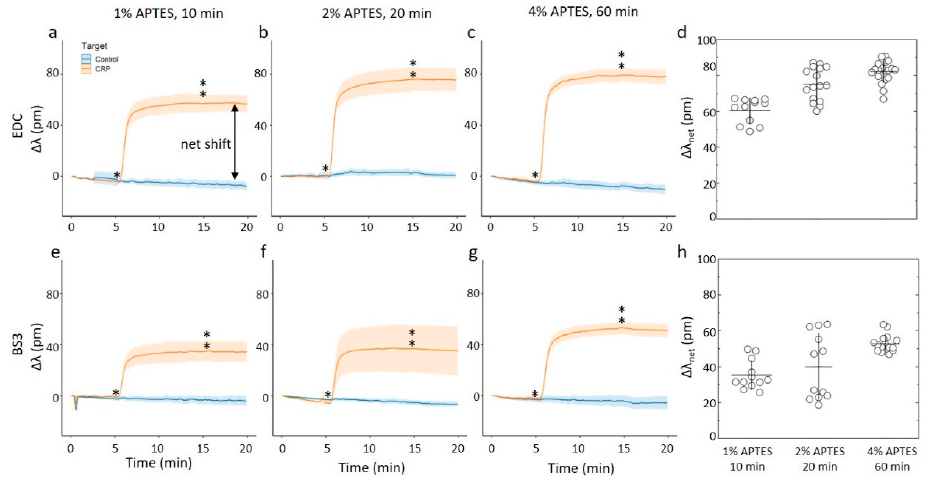
Figure 6. ( a – c , e – f ) Online measurements of CRP capture on ring resonator sensor chips silanized with APTES using 1 mM acetic acid as the silanization solvent. The assay steps consisted of a PBS-BSA rinse for 5 min before a 2.5 ug / mL CRP in BSA-PBS for 10 min and a final PBS-BSA rinse for 5 min. Single- and double-stars marks start and end of CRP in BSA-PBS step respectively. For these experiments, at least 12 rings were used for technical replicates. ( a – c ) CRP capture onto chips where the anti-CRP capture molecule has been immobilized using by carbodiimide chemistry onto chips silanized using APTES concentrations and durations of ( a ) 1% APTES, 10 min, ( b ) 2% APTES, 20 min, and ( c ) 4% APTES, 60 min. ( d ) The average net shift in resonance wavelength due to CRP capture onto the ring resonator chips with anti-CRP immobilized with by carbodiimide chemistry. ( e – g ) CRP capture onto chips where the anti-CRP capture molecule has been immobilized by the BS3 linker onto chips silanized using APTES concentrations and durations of ( e ) 1% APTES, 10 min, ( f ) 2% APTES, 20 min, and ( g ) 4% APTES, 60 min. ( h ) The average net shift in resonating wavelength due to CRP capture onto the ring resonator chips with anti-CRP immobilized with the BS3 linker.